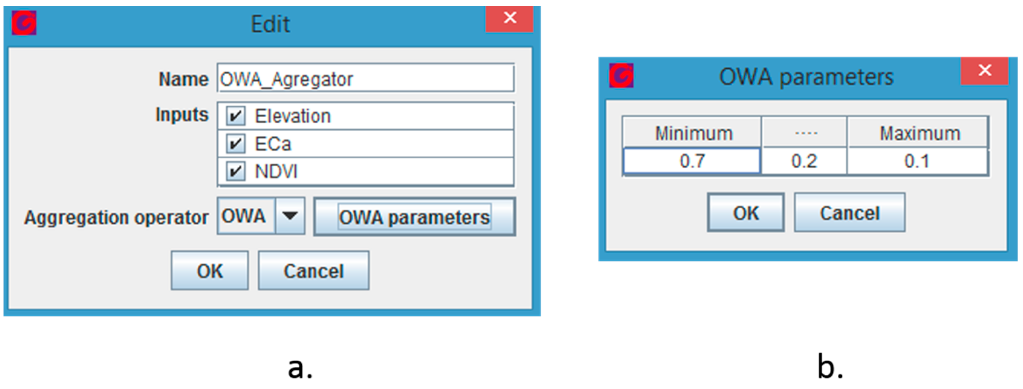
Figure 11. Parametrization of the Ordered Weighted Average (OWA) aggregator: ( a ) Selection of the layers to be aggregated; ( b ) setting of the OWA aggregator parameters. The weights for the minimum, medium and maximum values of univariate risk are respectively 0.7, 0.2 and